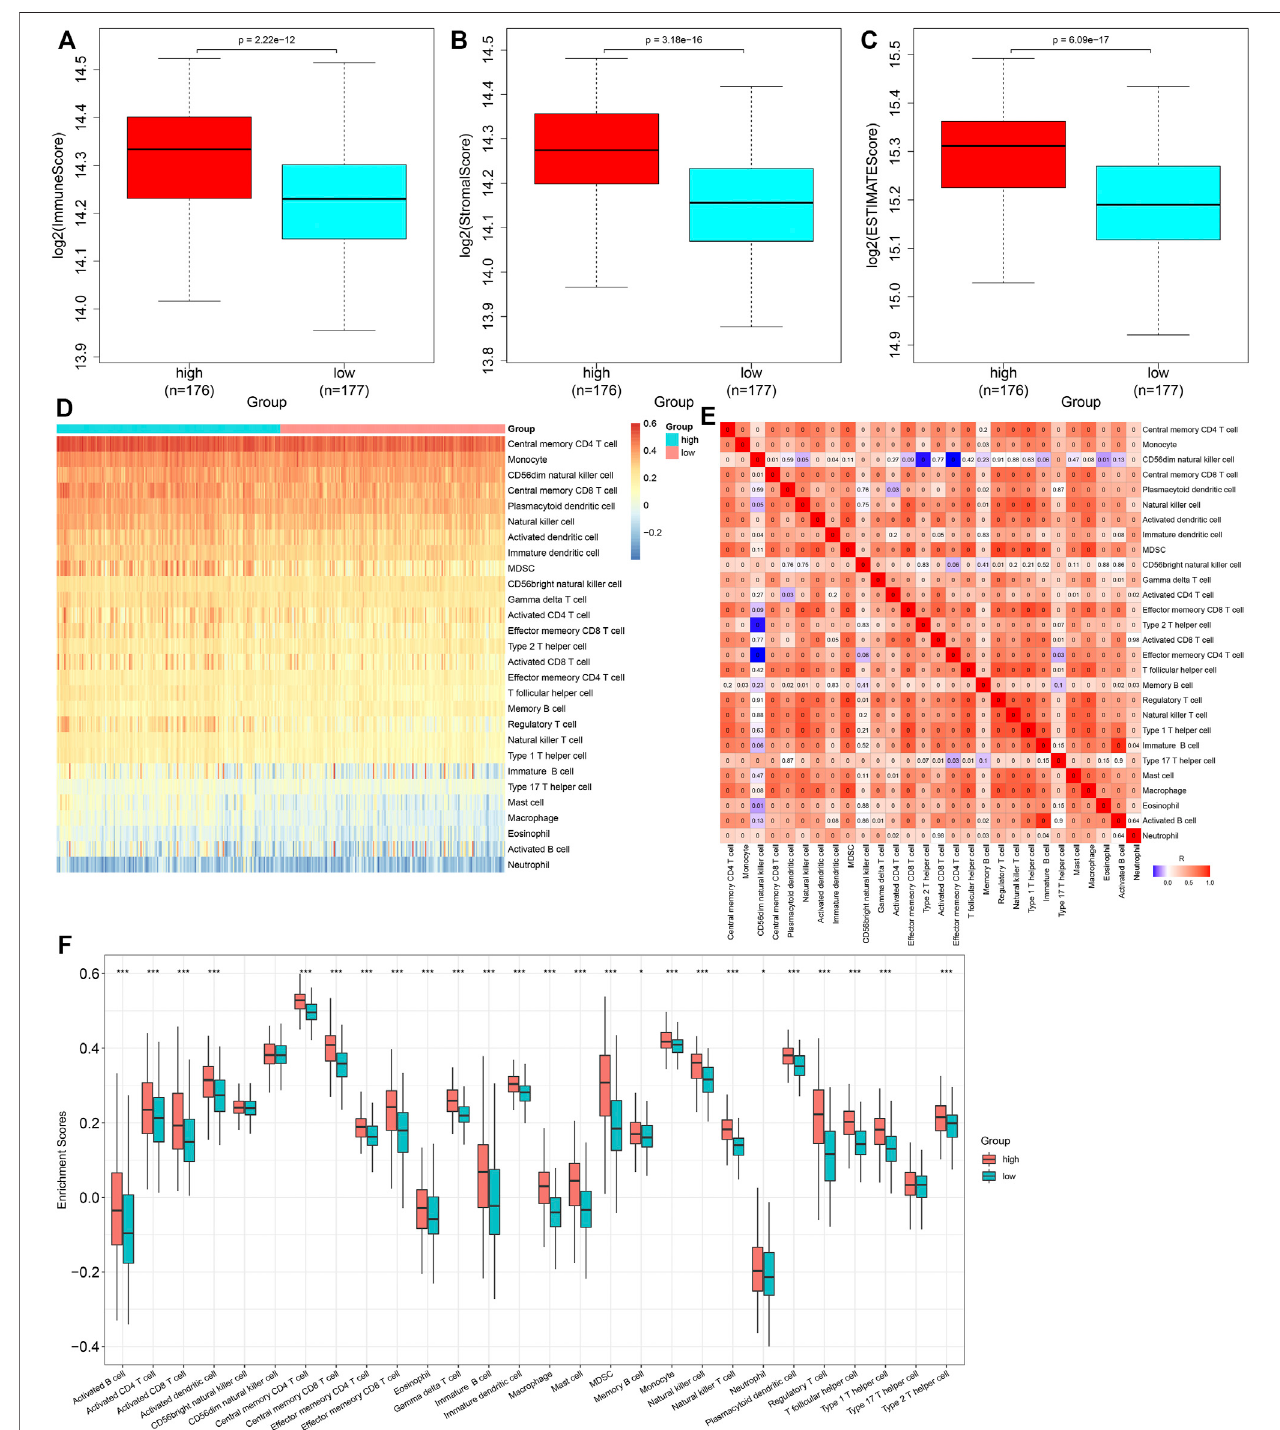
FIGURE 7 | Heterogeneity in immune cell in fi ltrations between high- and low-risk subgroups. (A – C) Comparison of immune and stromal scores, as well as ESTIMATE scores, between groups. (D) Distribution ofabundance levels ofimmunecells across GCtissues. (E) Heatmap visualizing the interactionsofdiverse immune cells across GC tissues. (F) Comparison of abundance levels of immune subpopulations between groups. * p < 0.05; *** p < 0.001.